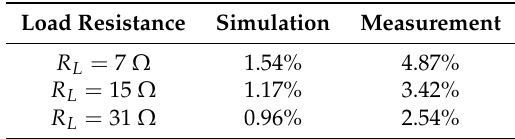
Table 4. DC bus voltage ripples comparison between simulation and measurement at V DC = 24 V and ω = 800